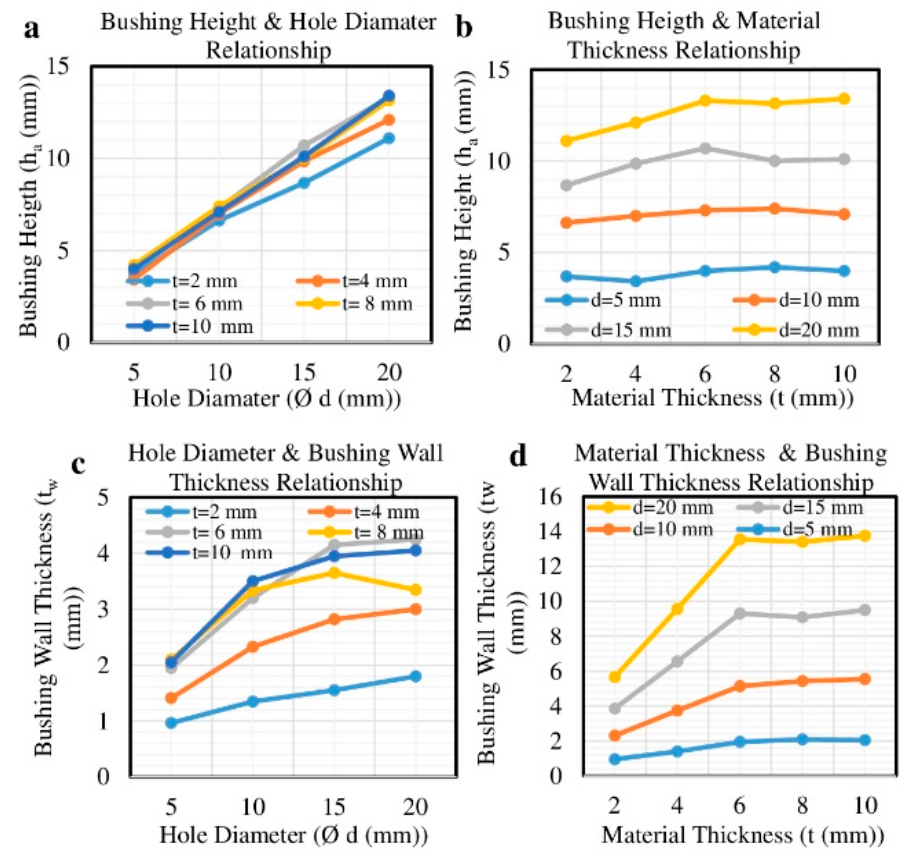
Figure 7. The effects of hole diameter and material thickness on ( a , b ) bushing height, ( c ) and ( d ) bushing wall.